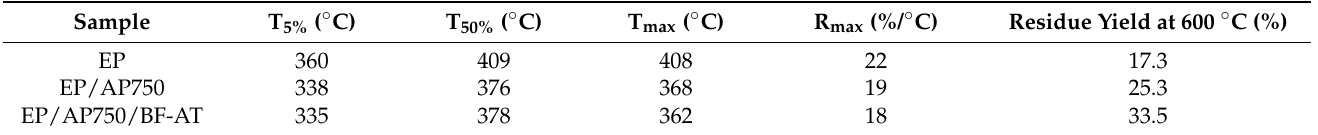
Table 2. Data obtained from TG and DTG curves of EP, EP/AP750, and EP/AP750/BF-AT. Sample